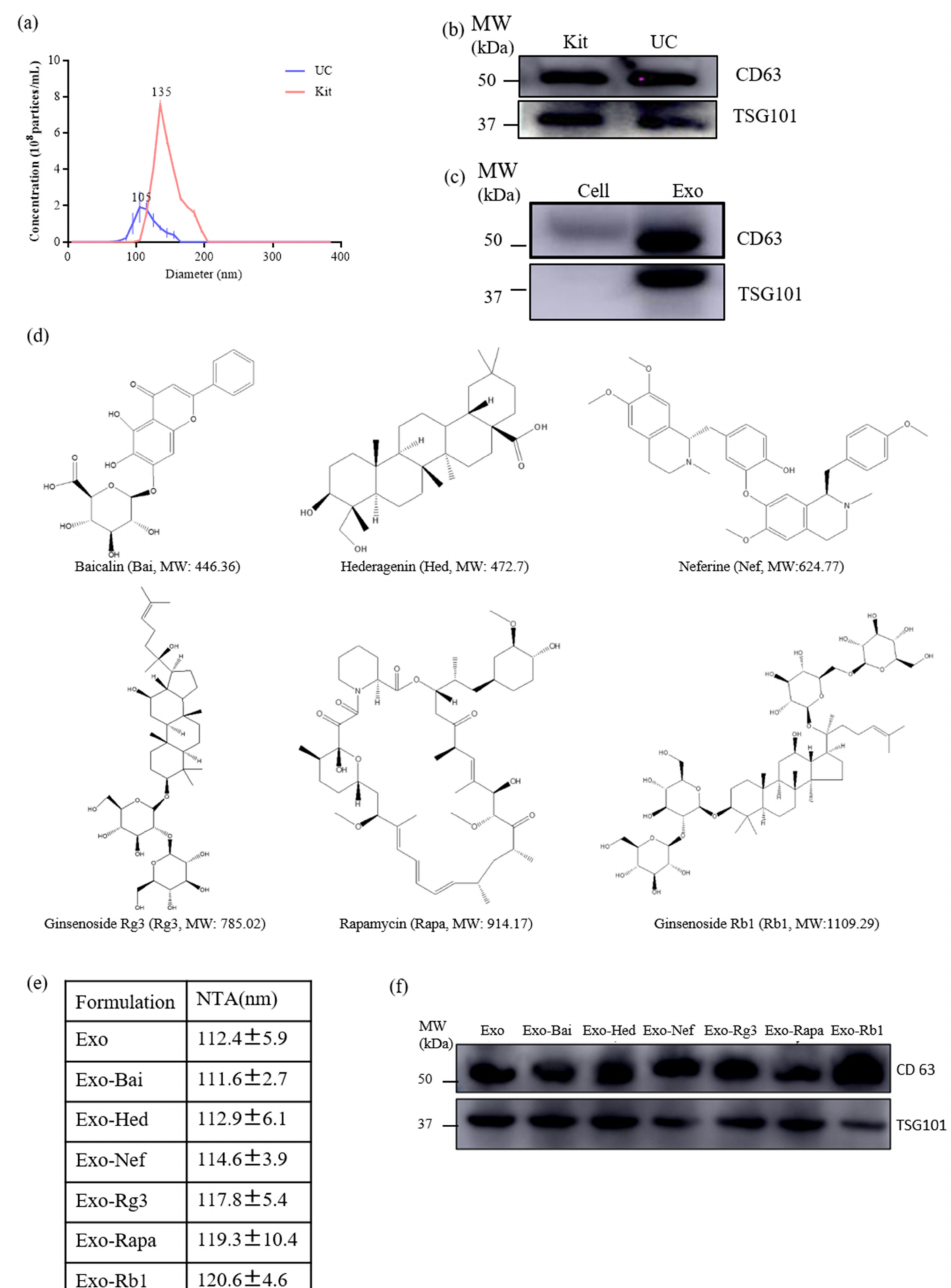
Figure 1. Characterization of the exosomes and natural compounds encapsulated exosomes. ( a ) The size (diameter, nm) of the exosome was measured by NTA. ( b ) Western blot analysis of the represen- tative exosome protein markers (TSG101 and CD63) from exosomes isolated from neuron-2a cells using a commercial kit (Kit) or ultra-centrifugation (UC). ( c ) Western blot analysis of the exosome markers on the total cell protein lysate (Cell) or the exosome only (Exo). ( d ) The chemical structures of baicalin (Bai, MW: 446.36 Da), hederagenin (Hed: MW: 472.7 Da), neferine (Nef: MW: 624.77 Da), ginsenoside Rg3 (Rg3, MW: 785.02 Da), rapamycin (Rapa, MW: 914.17 Da) and ginsenoside Rb1 (Rb1, MW: 1109.29 Da) are shown. ( e ) Sizes of the compounds encapsulated exosomes (Exo-Bai, Exo-Hed, Exo-Nef, Exo-Rg3, Exo-Rapa and Exo-Rb1) measured by NTA. ( f ) Western blot of the exosome markers in the proteins extracted from the above compounds encapsulated exosomes (Exo-Bai, Exo-Nef, Exo-Rg3, Exo-Rapa and Exo-Rb1). All of the experiments were performed as three independent